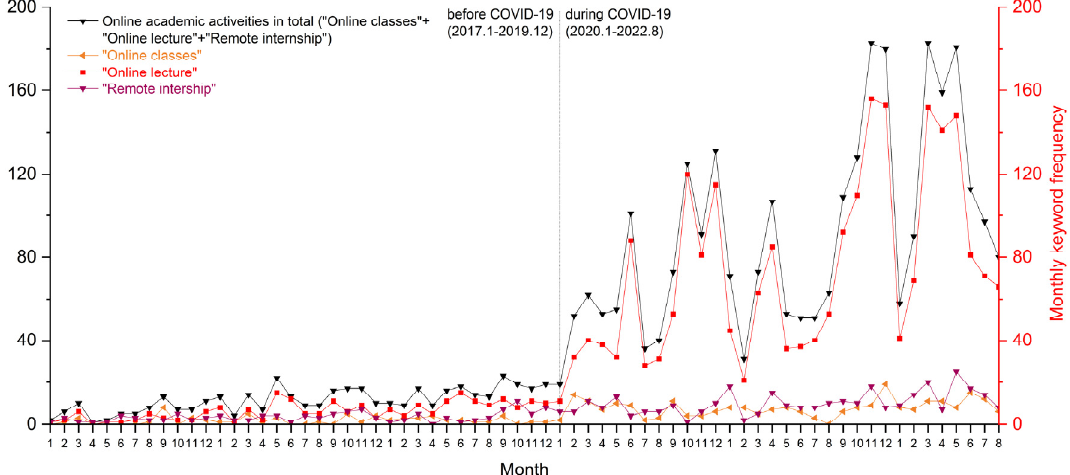
Figure 8. Monthly online-related keyword frequency: “Online classes”, “Online lecture”, and “Remote internship”.